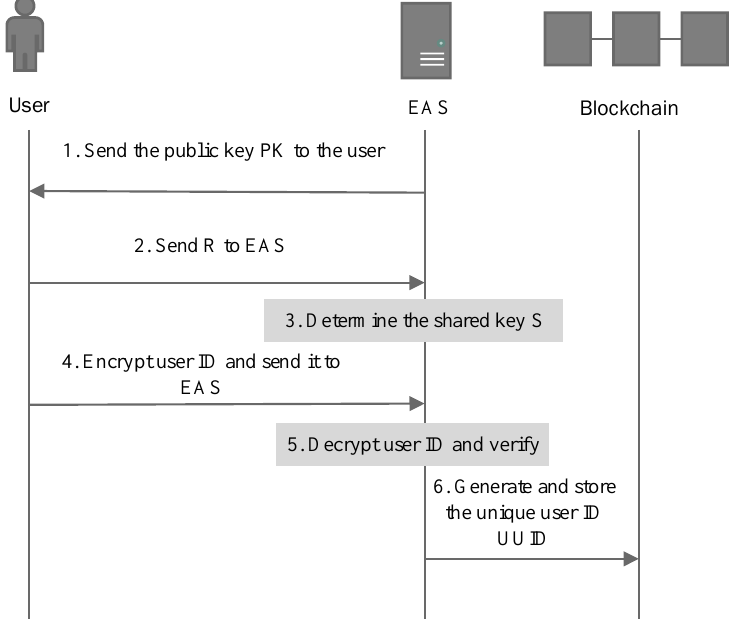
Figure 3. User Register.